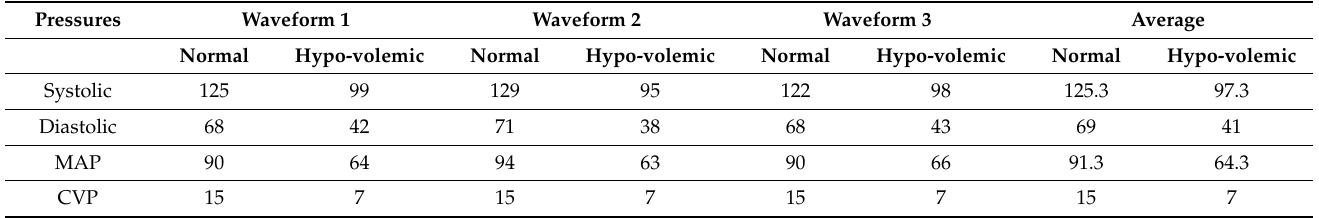
Figure 3. Arterial waveform results for the phantom platform. ( A – C ) Three distinct arterial wave- forms were generated at both normal and hypovolemic levels. Each plot shows at least 3 waves for both pressure settings. ( D ) Arterial in-plane doppler signal for the tissue phantom after adding flour to the arterial flow. Table 1. Summary of normal and hypovolemic circulating fluid pressure readings for arterial and venous flow. Results are shown for three waveform examples and as mean results. For simplicity, arterial flow is described as systolic, diastolic, and mean arterial pressure (MAP), while central venous pressure (CVP) is shown for venous flow. All values are in units of